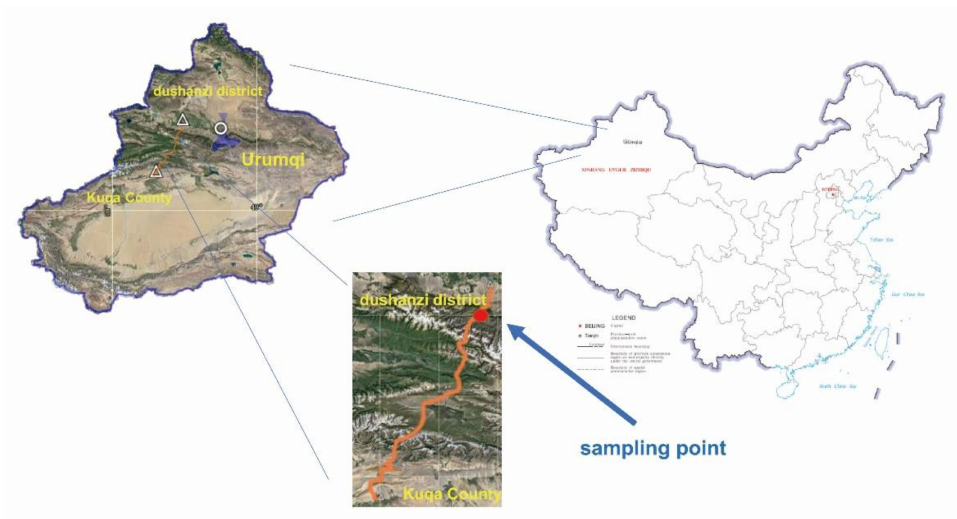
Figure 1. Location map of sampling